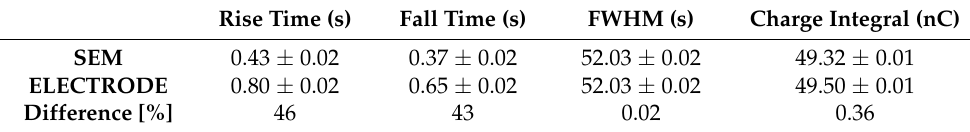
Table 2. Comparisons of the main parameters of the curves reported in Figure 2. Rise Time